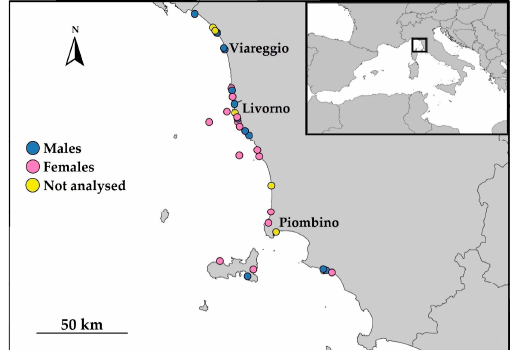
Figure 1. Map of the Tuscany coast showing the stranding locations of T. truncatus analyzed (males and females) for dietary studies as well as those specimens not analyzed, such as calves and individuals with empty stomachs.